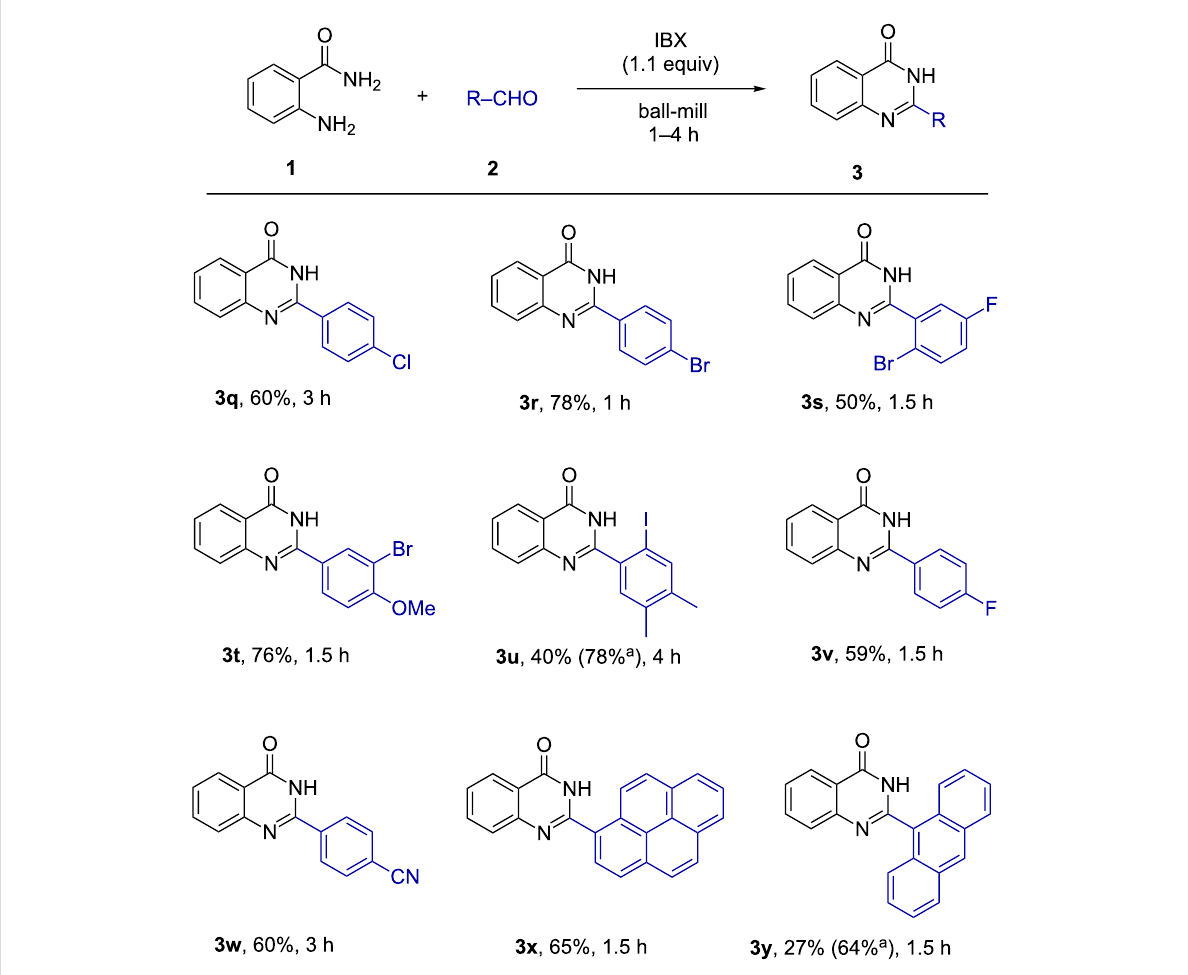
Figure 4: Synthesis of quinazolin-4(3 H )-one derivatives from reaction of 1 and solid aldehydes. a Yields with respect to recovered aldehydes, for com- pound 3y , IBX was added after 1 h.